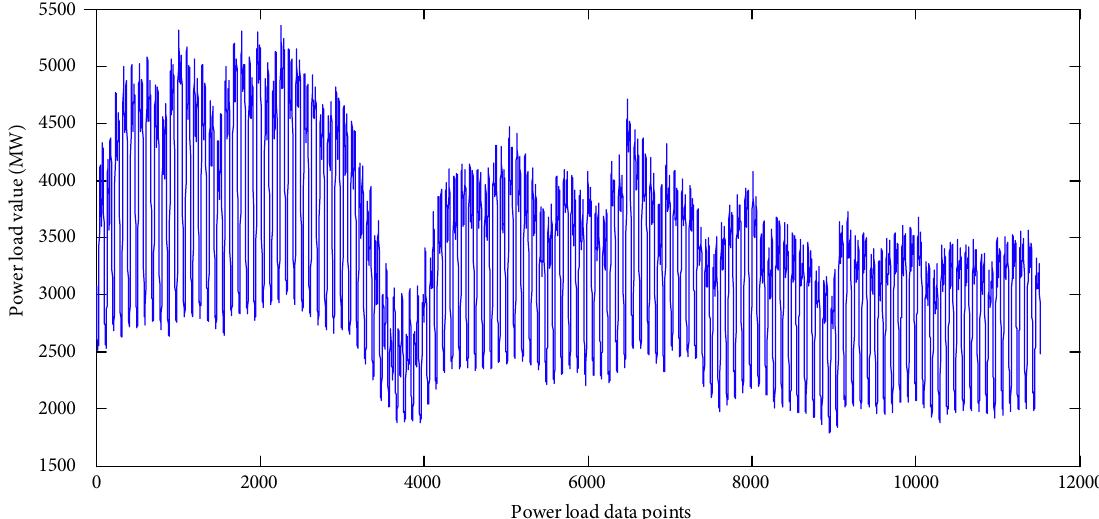
Figure 2: Power system load